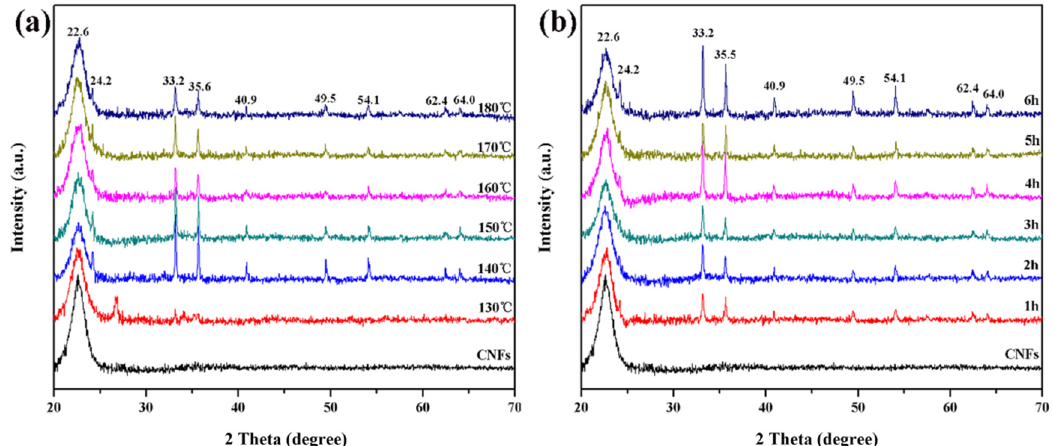
Figure 5. XRD patterns of Fe 2 O 3 /CNFs: ( a ) effect of reaction temperature; ( b ) effect of reaction time.